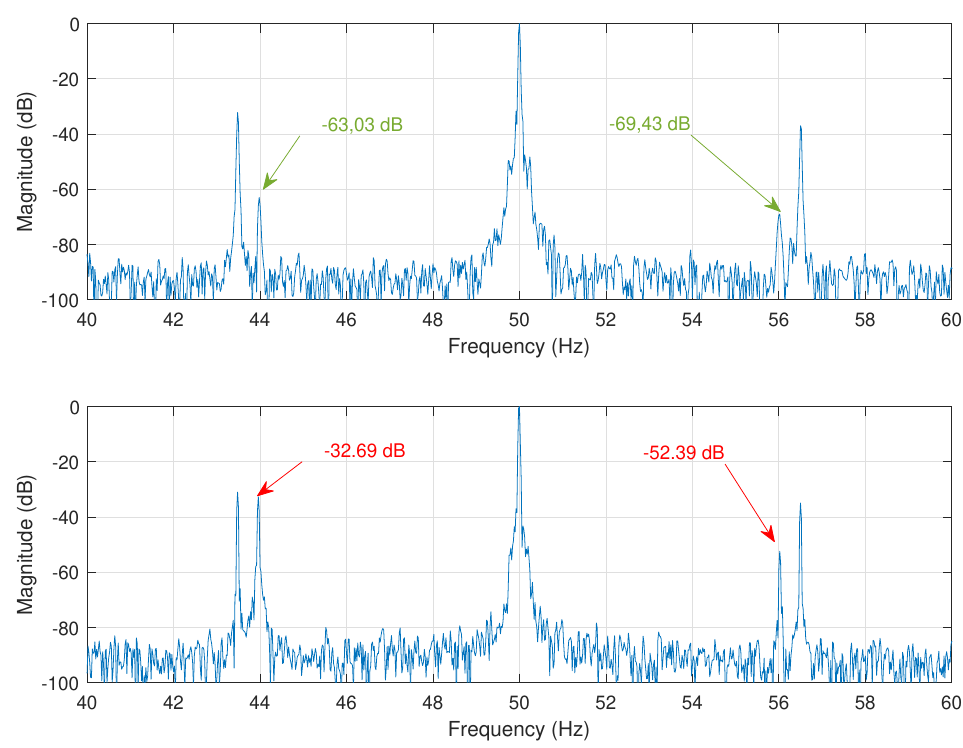
Figure 14. Spectrum of the experimental motor in healthy conditions ( top ); and with a single broken bar ( bottom ). The position and magnitude of the fault harmonics (LSH and USH) are indicated with arrows.